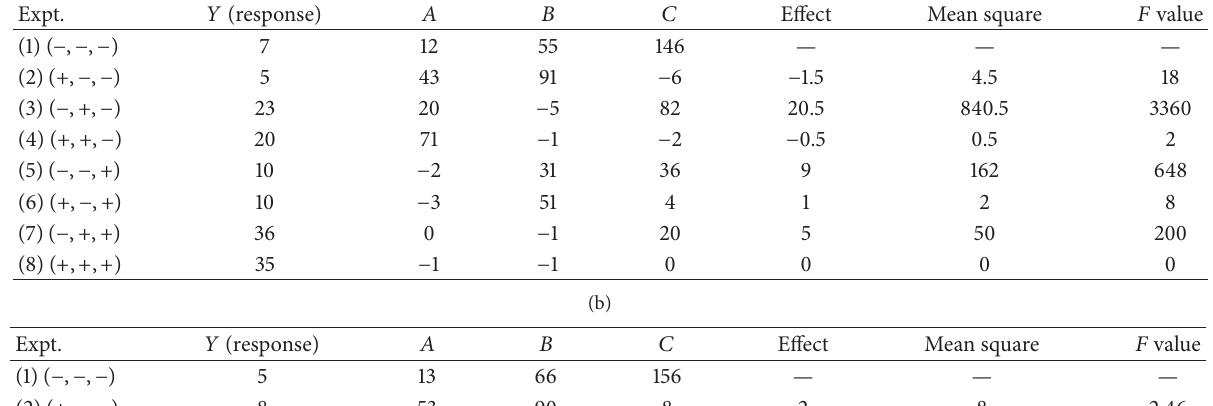
Table 2: (a) Yates analysis and ANOVA for acid degradation. (b) Yates analysis and ANOVA for alkali degradation. (a)